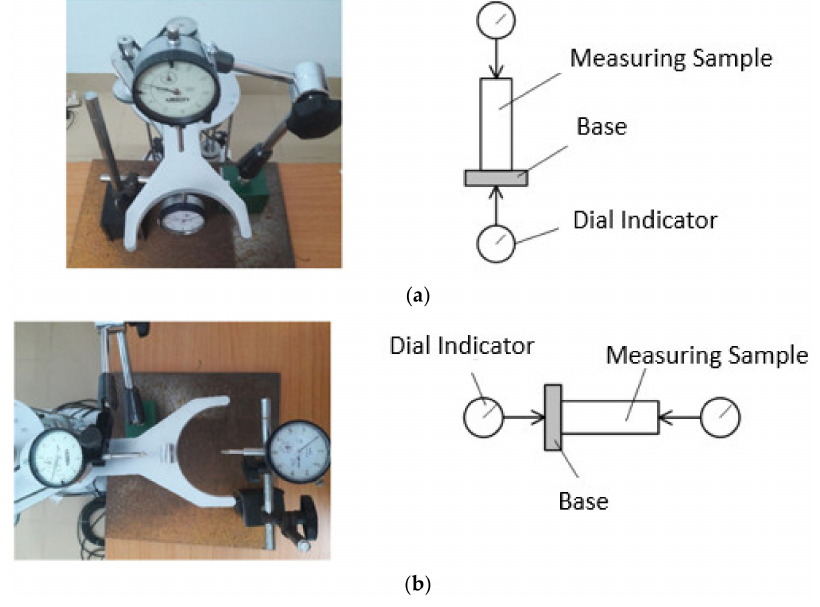
Figure 20. Experiments in mechanical measurement: ( a ) Z-axis, ( b ) R-axis. Results of the mechanical calibration for each linear / rotational movement over a specific